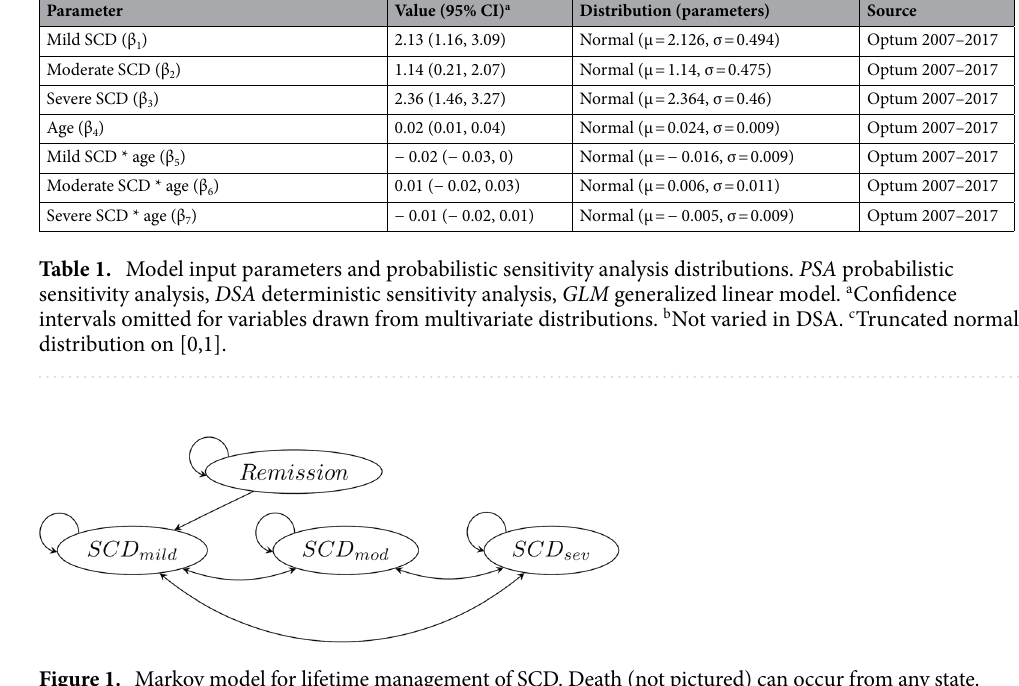
Figure 1. Markov model for lifetime management of SCD. Death (not pictured) can occur from any state. Abbreviations: SCD sickle cell disease, mild mild disease (zero crises per year), mod moderate disease (< 2 crises per year), sev severe disease (≥ 2 crises per